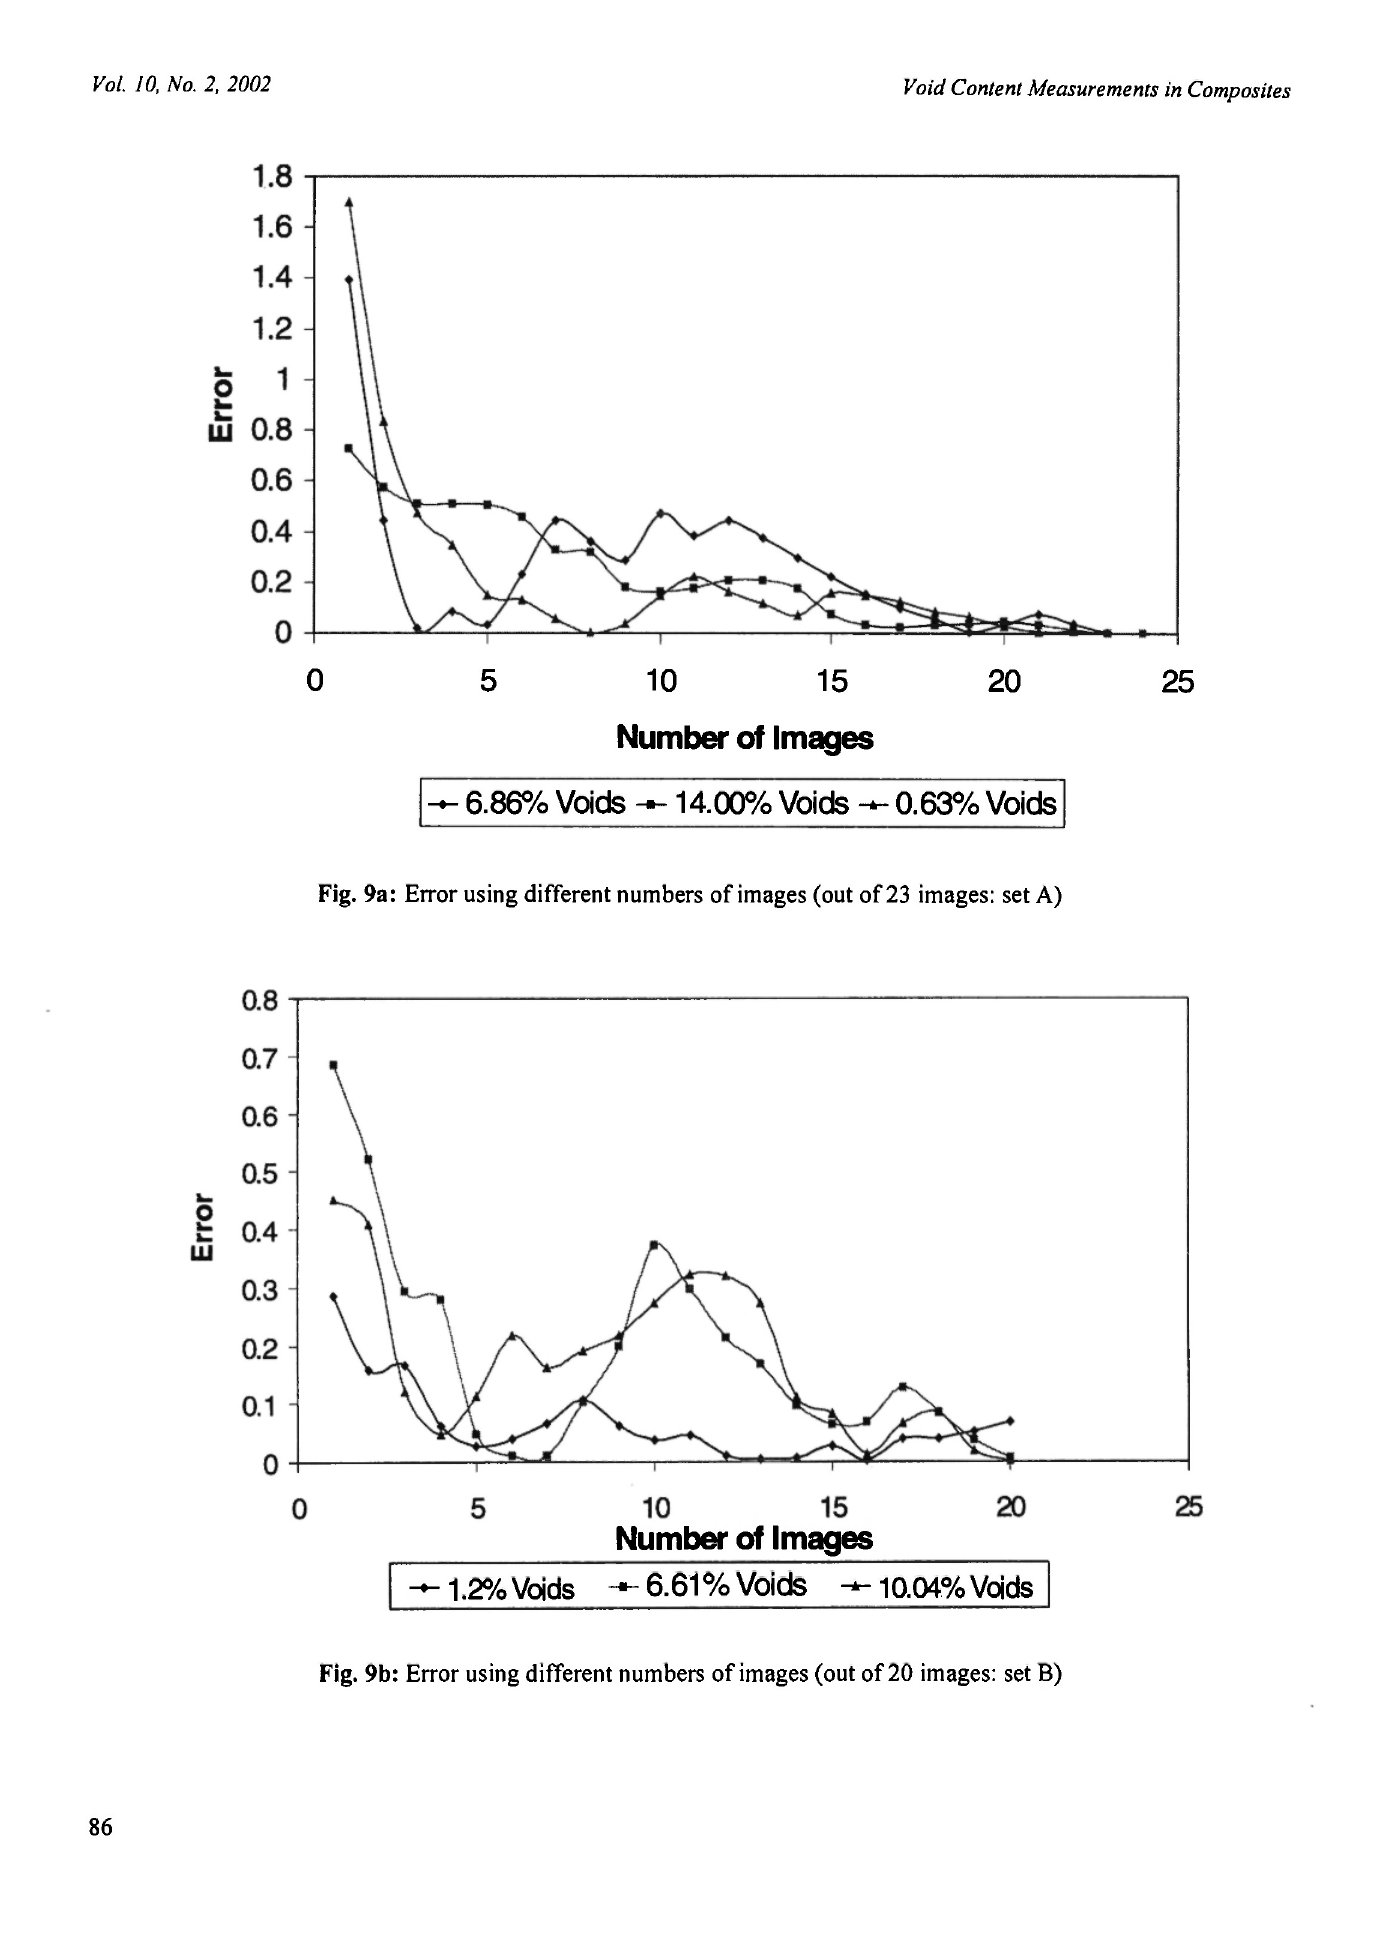
Fig. 9b: Error using different numbers of images (out of 20 images: set